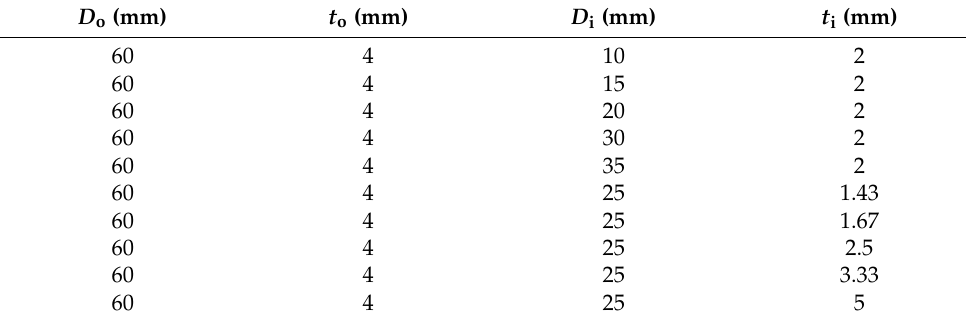
Table 6. Cases with different geometrical parameters of the inner pipe.